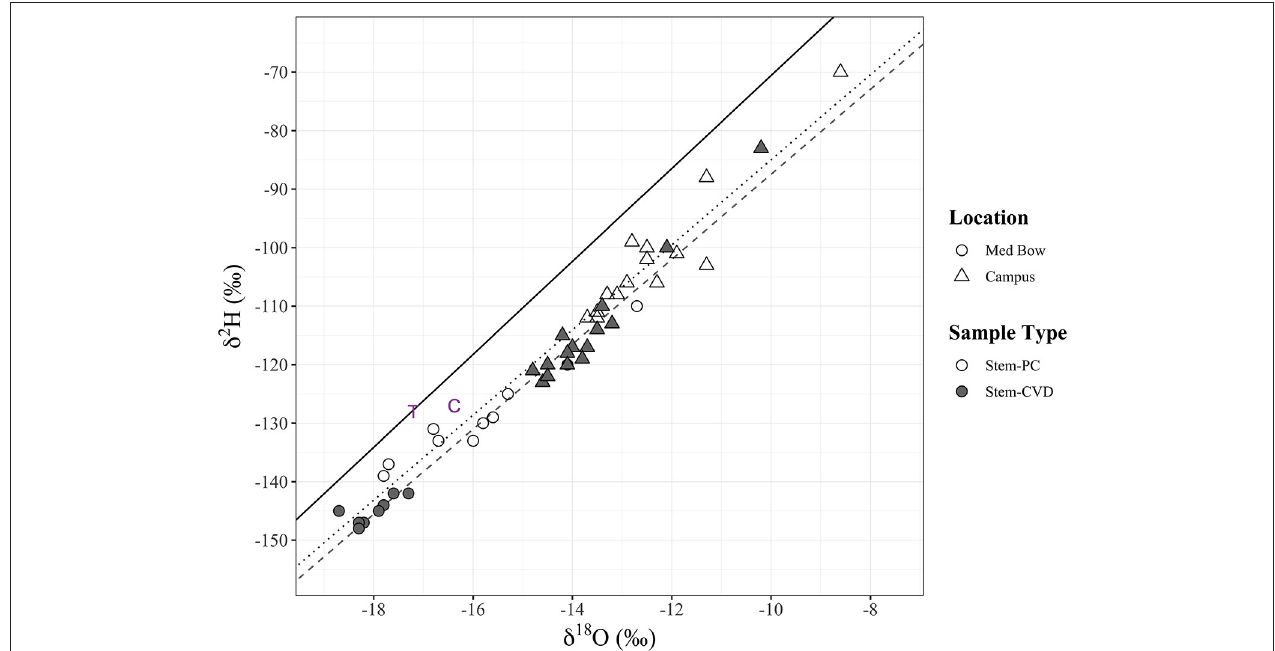
FIGURE 3 | All stem xylem water stable isotope samples ( n = 48) in dual isotope space ( δ 2 H and δ 18 O). Sample type and sampling location are denoted by fill and shape, respectively: Stem-PC (no fill), Stem-CVD (gray fill), Med Bow (circles), and Campus (triangles). Plot includes the LMWL (black solid line) and two additional data points of tap water sample (purple “T”) used for controls and the mean for control samples (purple “C”). Significant positive relationships were found between δ 2 H and δ 18 O for each sample type with trend lines included in plot: Stem-PC linear model (dotted black line) and Stem- CVD linear model (dashed gray line) (see end of results section for